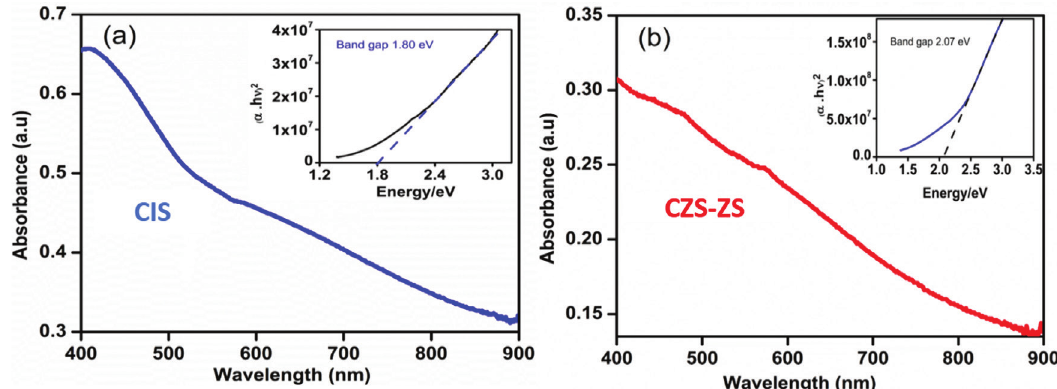
Figure 6: UV-Vis absorption spectra of (a) CIS and (b) CZS-ZS thin films. Insets are the corresponding Tauc's plot indicating band gap